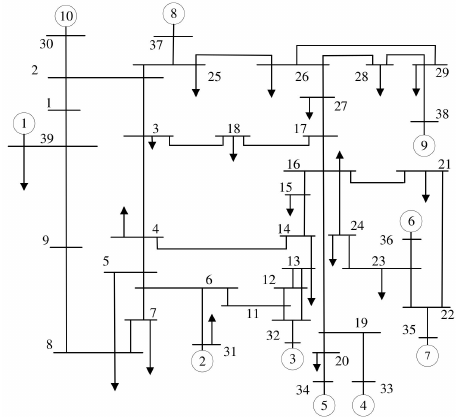
Figure 12. Modified IEEE-39 node network topology.